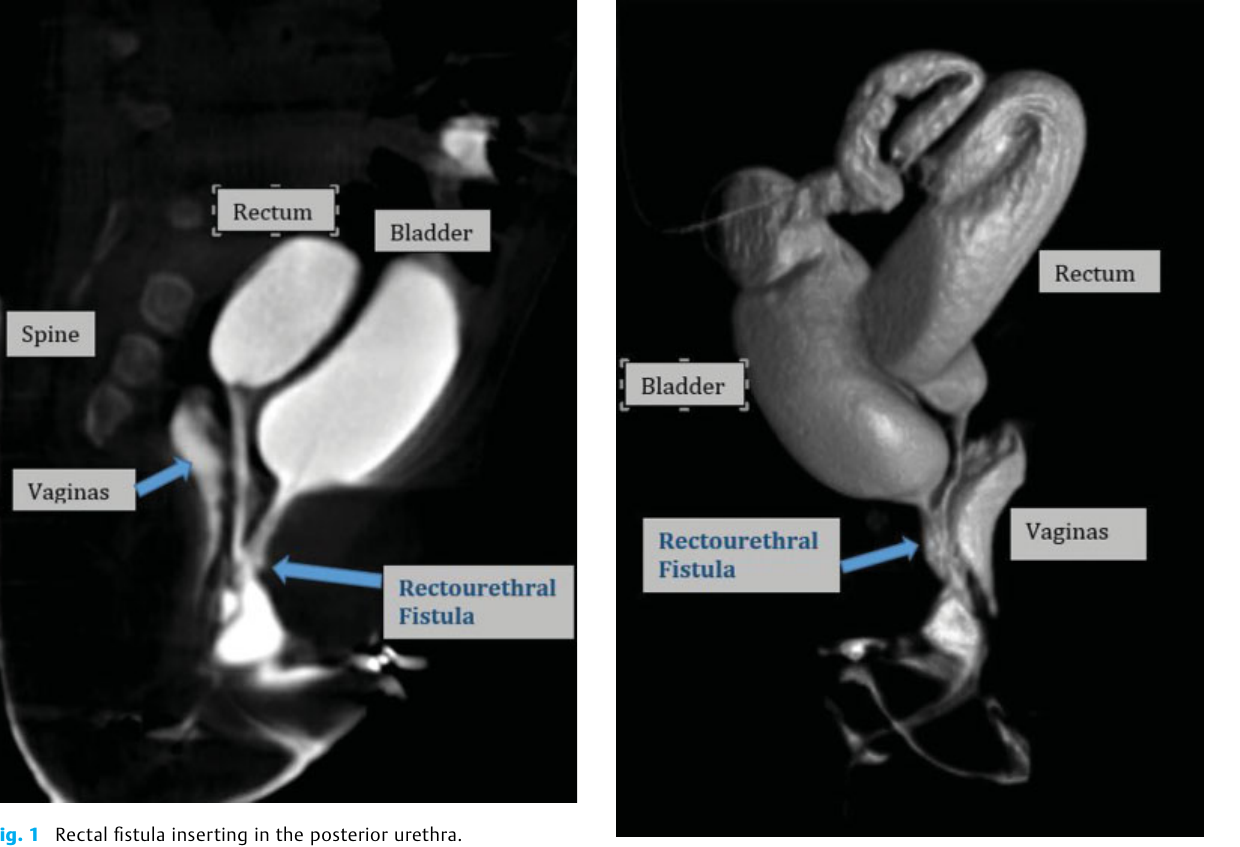
European Journal of Pediatric Surgery Reports Vol. 7 No.